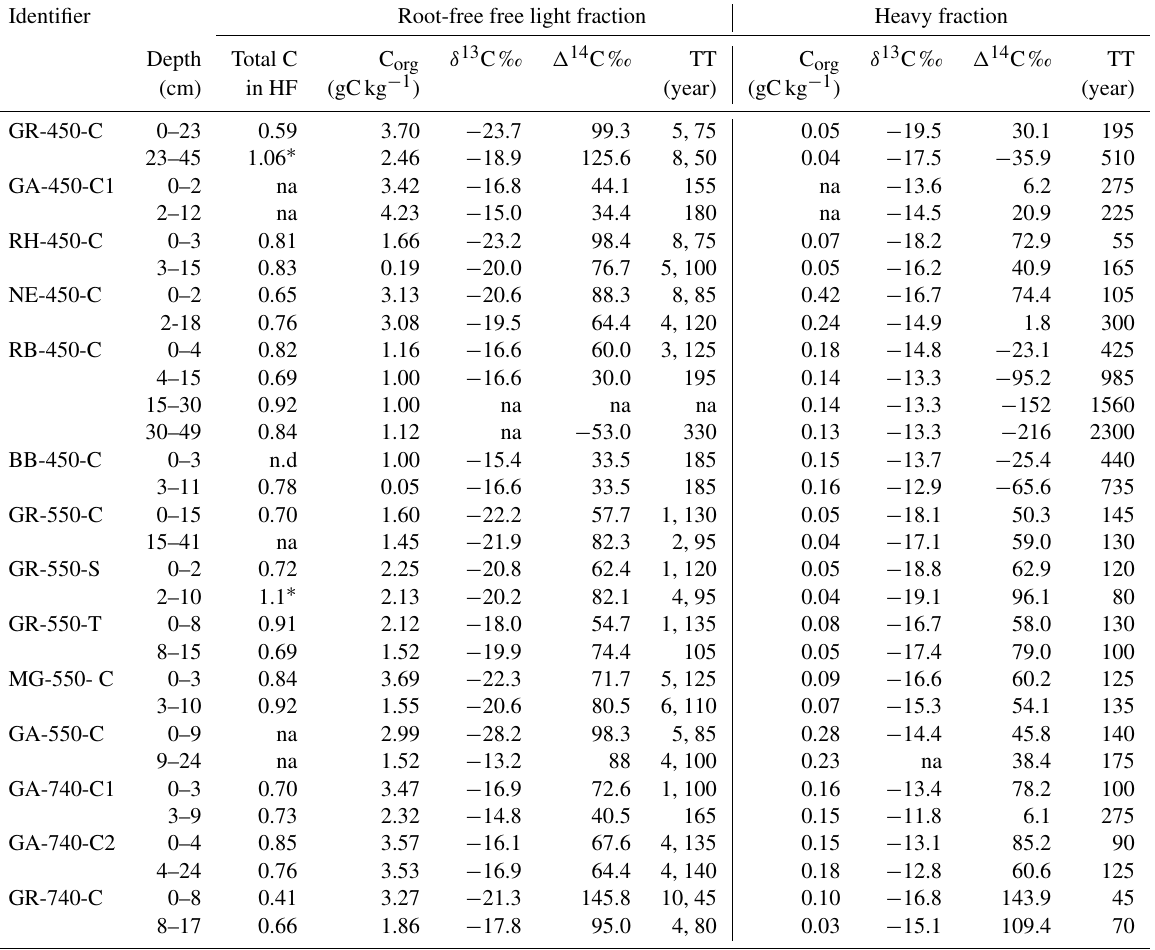
Table 3. Carbon and carbon isotope signatures of heavy (>1.7gcc − 1 ) and root-free free light fraction carbon. Turnover times (TTs) were estimated using the steady state, one-pool model described in the text. When two TTs were possible, we show both options for the root-free fLF but only the longer one for the heavy